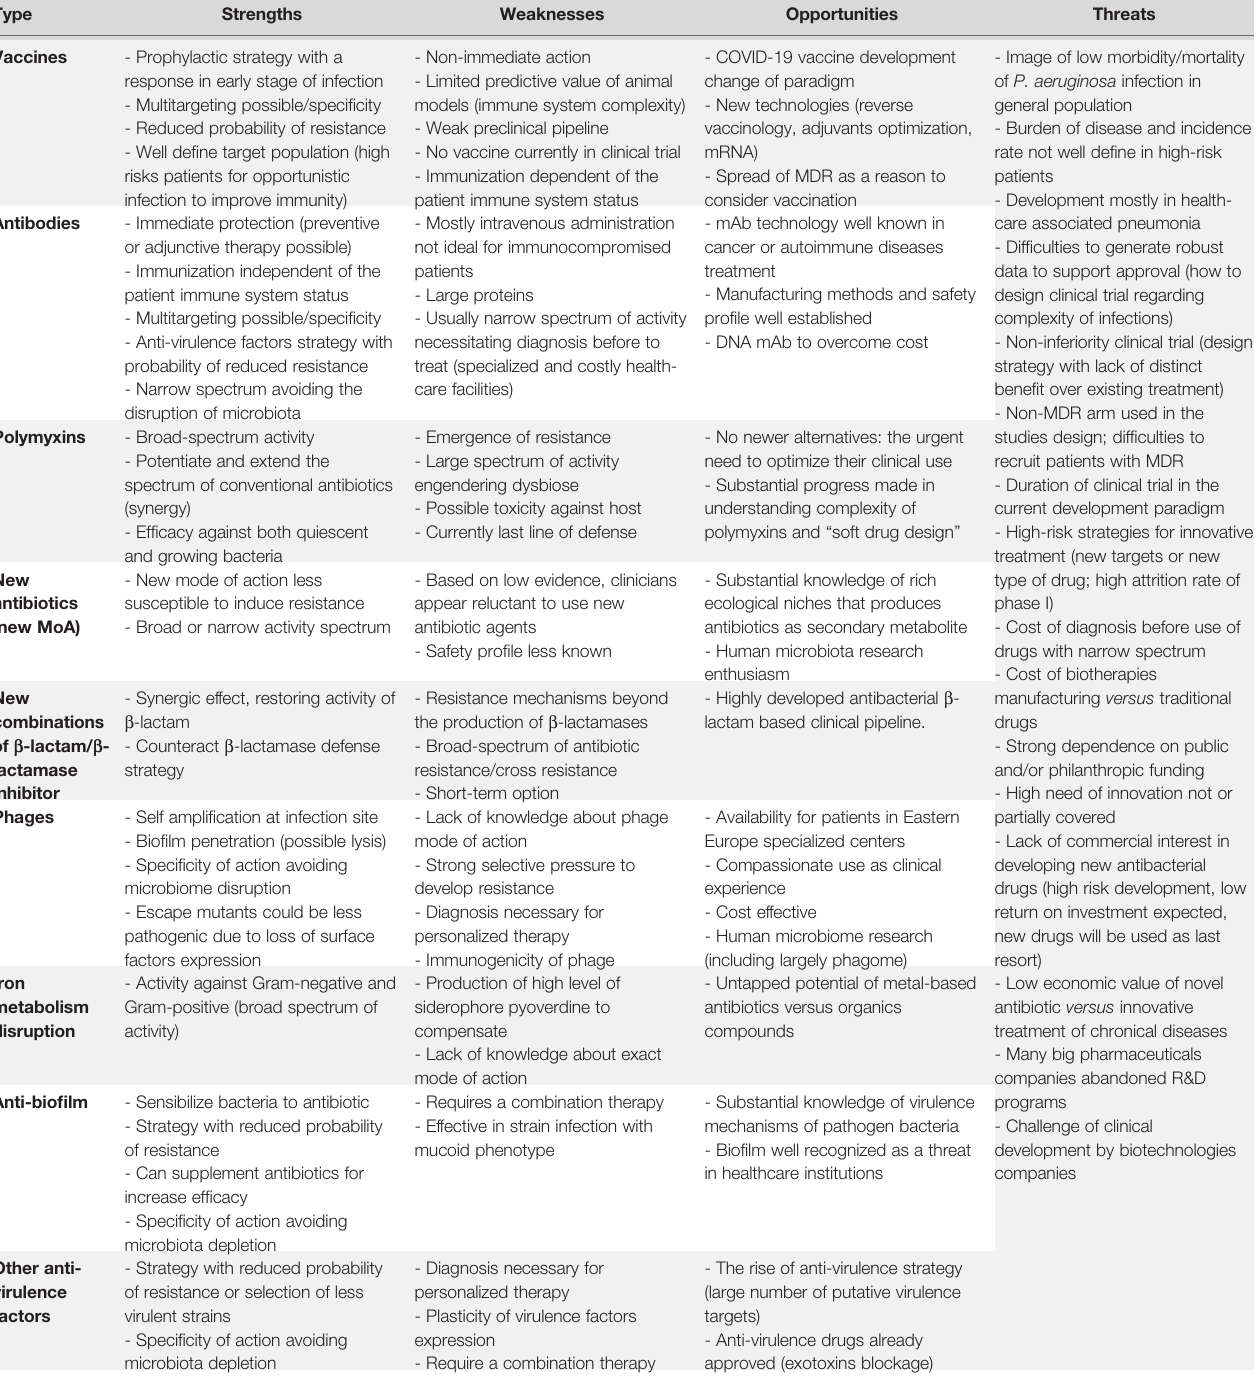
TABLE 1 | Strengths and weaknesses (internal factors), opportunities and threats (external factors) of each class of treatment in clinical development against P. aeruginosa.